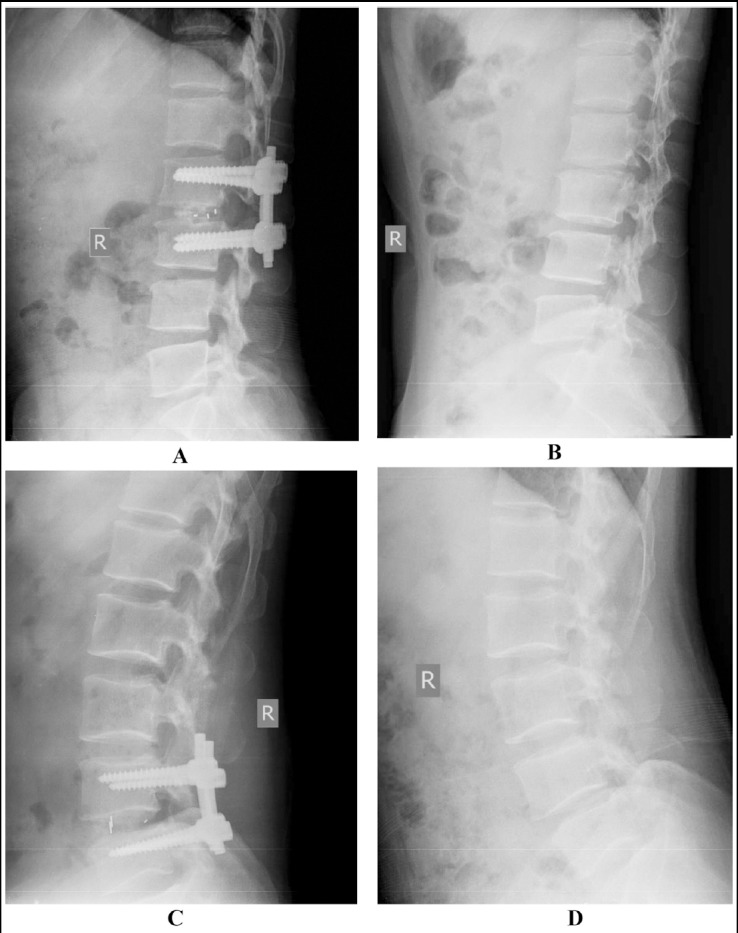
Imaging changes of typical cases before and two years after surgery.A and C: Pre-operative lateral X-ray film;B and D: Lateral X-ray film after bone graft fusion 2 years after operation.